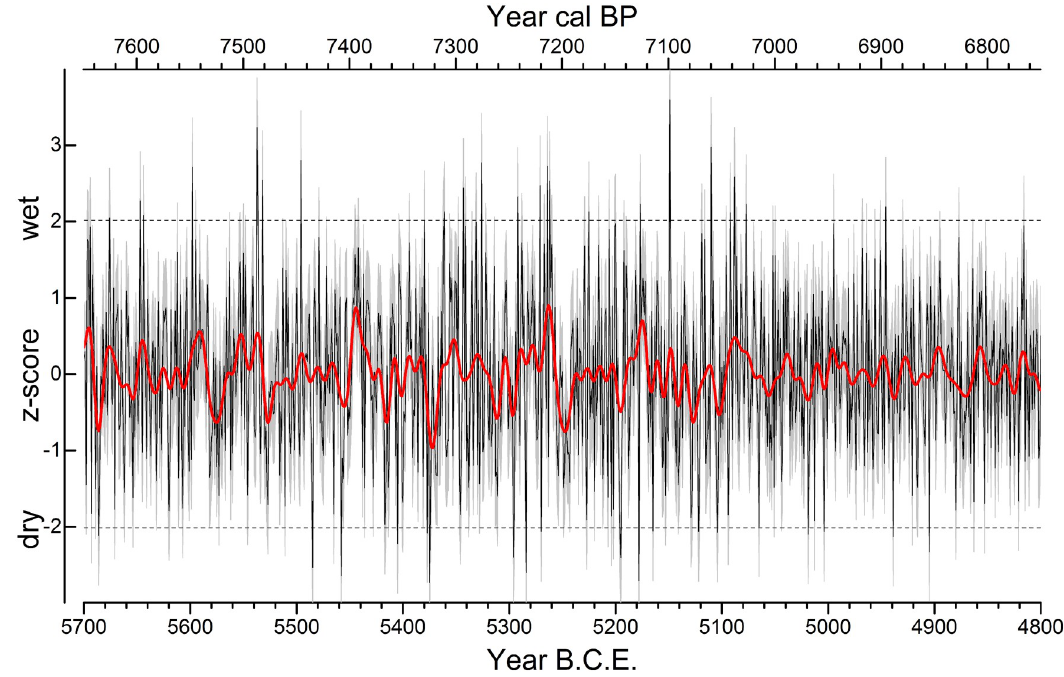
Fig 6. Dynamic of seasonal (black; Mean Absolute Error, MAE = grey shaded) and decadal (red) variability of spring-summer precipitation in southern Germany between 5700 and 4800 B.C.E. Dashed lines represent ± 2 standard deviations.